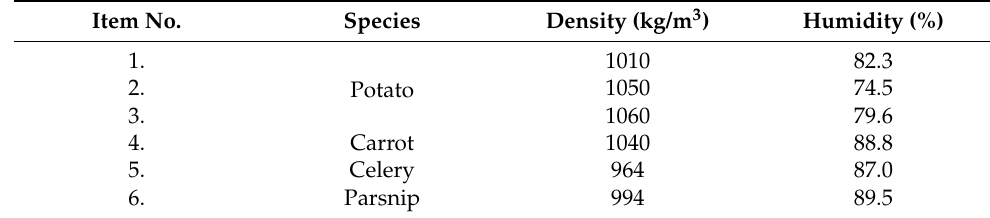
Table 4. The average density and average humidity of the vegetables were investigated [22]. Item No.